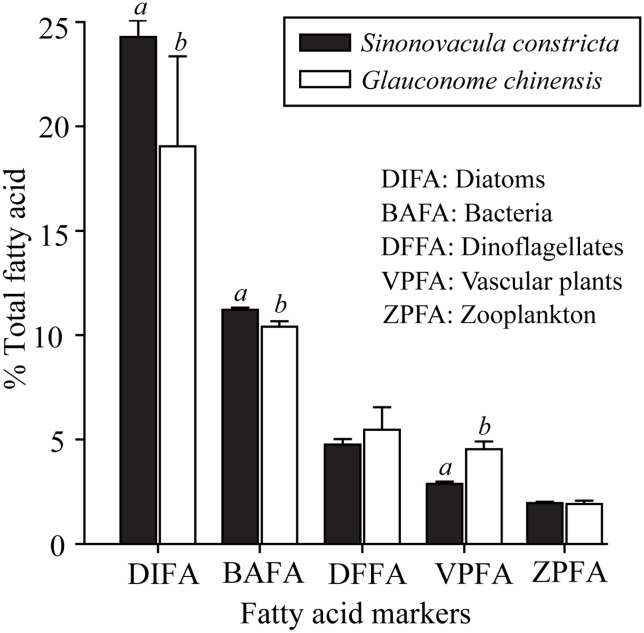
Relative percentages of fatty acid markers (diatom, bacteria, dinoflagellates, vascular plants and zooplankton) from Sinonovacula constricta and Glauconome chinensis in summer.Different superscript letters (a, b) refer to significant differences between two bivalve species (Tukey HSD test, P < 0.05).